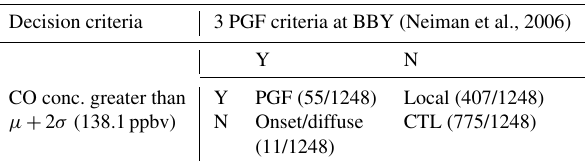
Table 1. Decision tree used for filtering measurement periods, and the resulting number of hourly periods (/total) in each